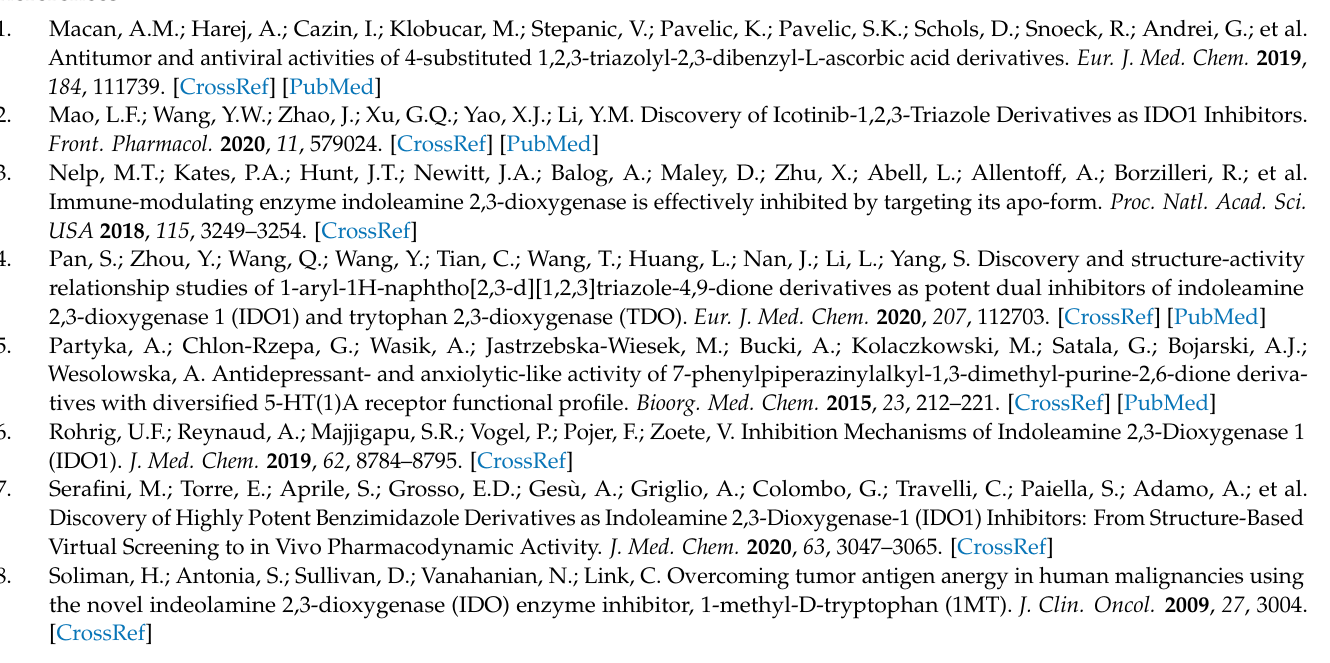
H NMR spectrum (600 MHz, DMSO- d 6 ) of compound 3c ; Figure S4: 1 H NMR spectrum (600 MHz, DMSO- d 6 ) of compound 3d ; Figure S5: 1 H NMR spectrum (600 MHz, DMSO- d 6 ) of compound 3e ; Figure S6: 1 H NMR spectrum (600 MHz, DMSO- d 6 ) of compound 3f ; Figure S7: 1 H NMR spectrum (600 MHz, DMSO- d 6 ) of compound 3g ; Figure S8: 1 H NMR spectrum (600 MHz, DMSO- d 6 ) of compound 3h ; Figure S9: 1 H NMR spectrum (600 MHz, DMSO- d 6 ) of compound 3i ; Figure S10: 1 H NMR spectrum (600 MHz, DMSO- d 6 ) of compound 5a ; Figure S11: 1 H NMR spectrum (600 MHz, DMSO- d 6 ) of compound 5b ; Figure S12: 1 H NMR spectrum (600 MHz, DMSO- d 6 ) of compound 5c ; Figure S13: 1 H NMR spectrum (600 MHz, DMSO- d 6 ) of compound 5d ; Figure S14: 1 H NMR spectrum (600 MHz, DMSO- d 6 ) of compound 5e ; Figure S15: 1 H NMR spectrum (600 MHz, DMSO- d 6 ) of compound 5f ; Figure S16: 1 H NMR spectrum (600 MHz, DMSO- d 6 ) of compound 7a ; Figure S17: 1 H NMR spectrum (600 MHz, DMSO- d 6 ) of compound 7b ; Figure S18: 1 H NMR spectrum (600 MHz, DMSO- d 6 ) of compound 7c ; Figure S19: 1 H NMR spectrum (600 MHz, DMSO- d 6 ) of compound 7d ; Figure S20: 1 H NMR spectrum (600 MHz, DMSO- d 6 ) of compound 7e ; Figure S21: 1 H NMR spectrum (600 MHz, DMSO- d 6 ) of compound 7f